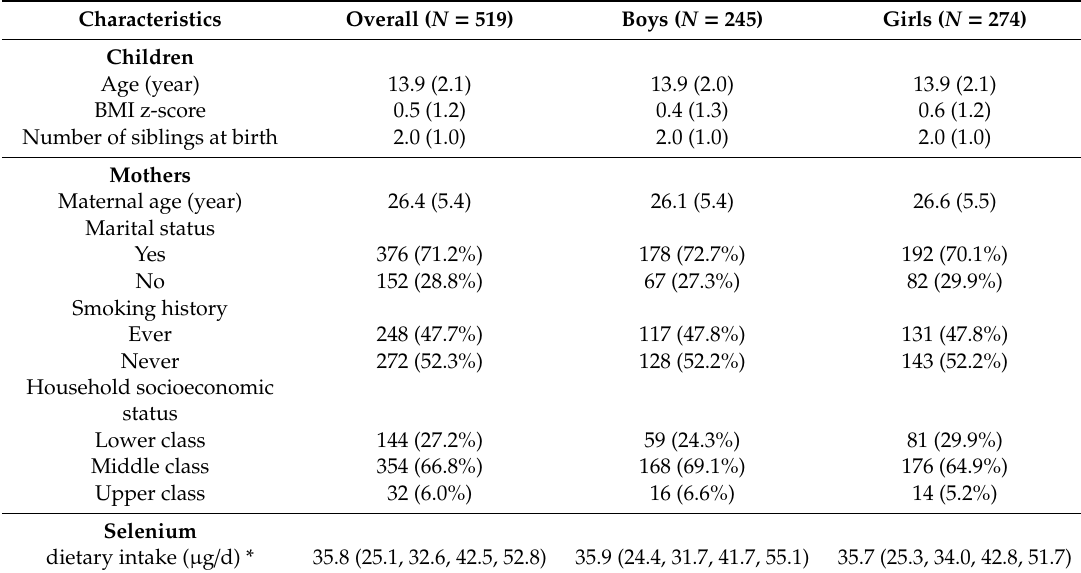
Table 1. Demographic characteristics and selenium consumption of participants living in Mexico